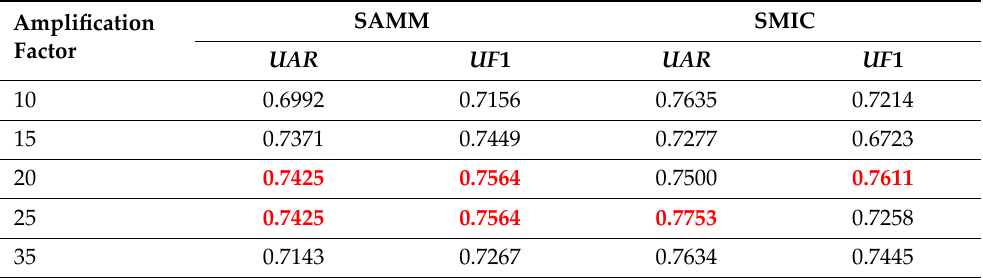
Table 8. Performance of DS‑3DCNN (without domain adaptation) with different amplification fac‑ tors in EVM.